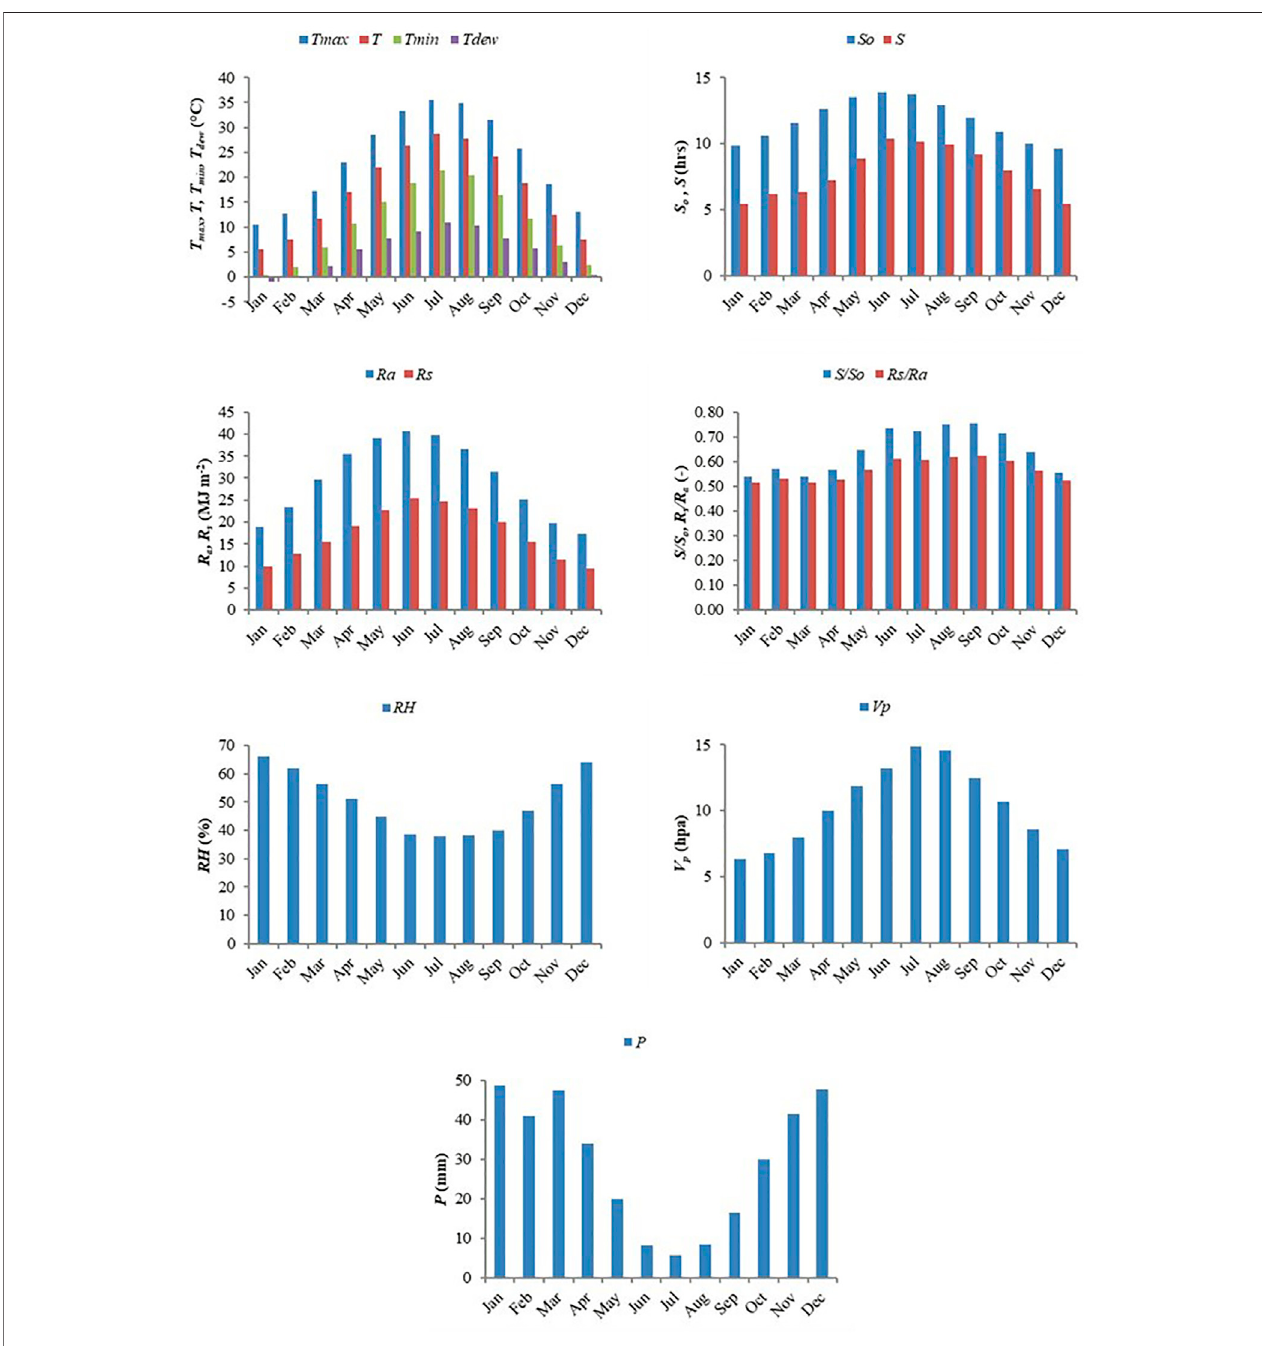
FIGURE 2 | Long-term mean monthly meteorological variables in the study